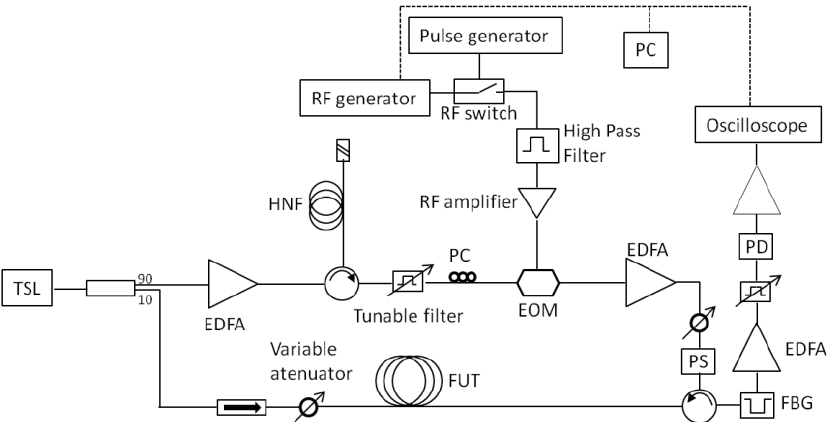
Figure 4. Scheme of the BOTDA setup used for our measurements. TSL: tunable semiconductor laser; PC: polarization controller; PD: photodetector; HNF: highly nonlinear fiber; PS: polarization scrambler; FUT: fiber under